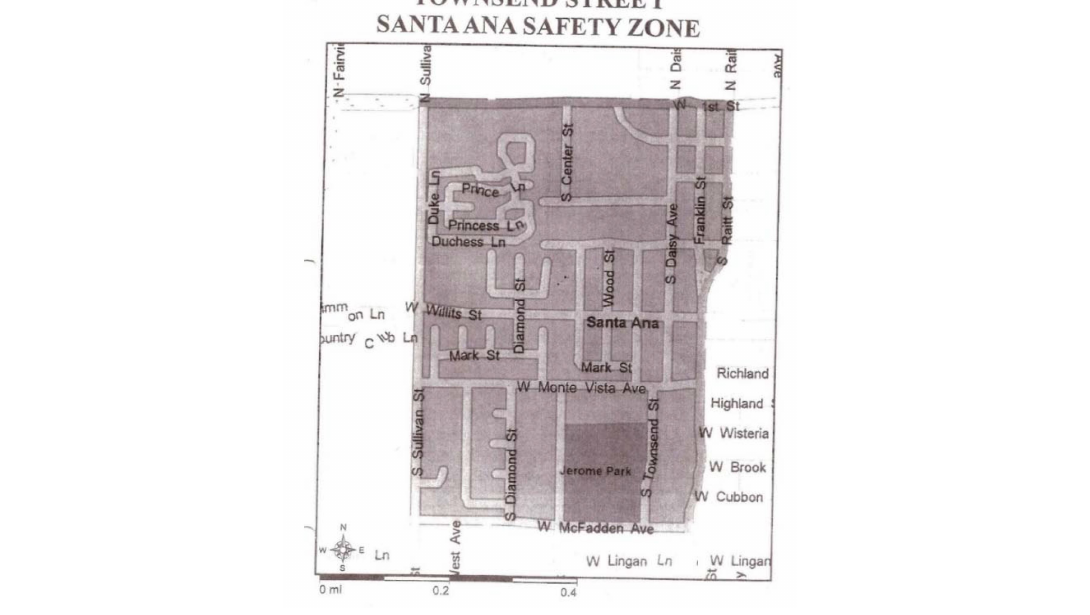
Figure 5. Santa Ana Police map of Townsend. Townsend does not have the highest crime rate in its section of the city, but it is adjacent to neighbourhoods the city wants to redevelop (Source: photo from a Powerpoint projection at a public forum, September